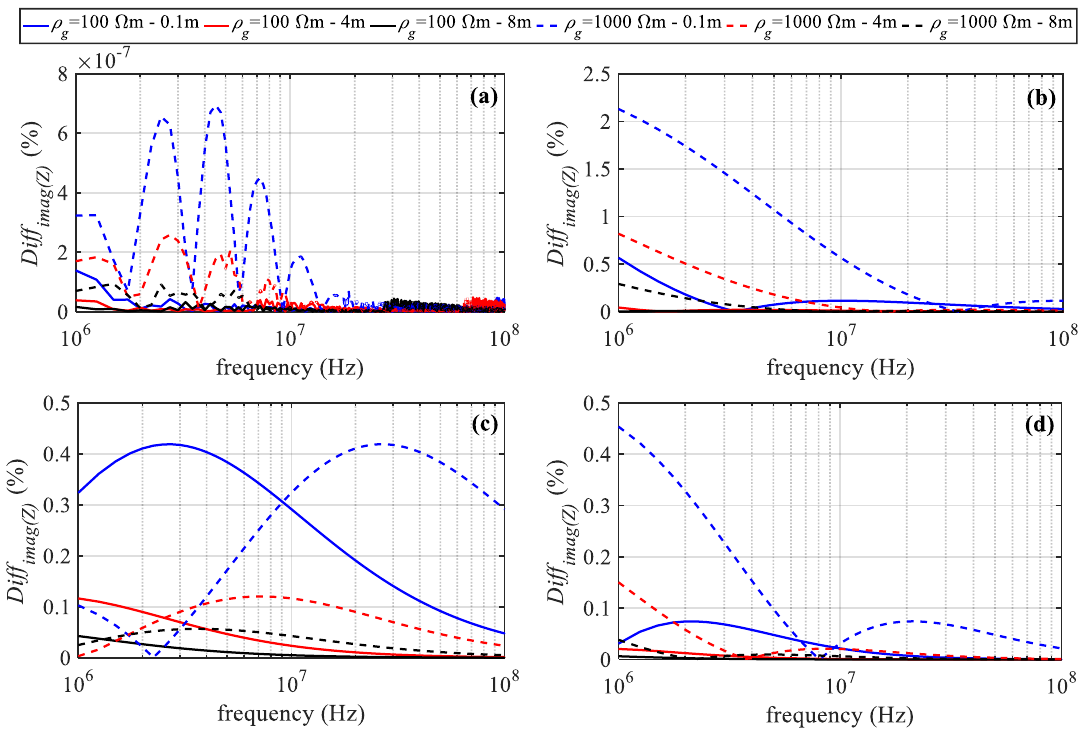
Figure 16. Di ff erences in the imaginary part of Z 13 in NB using the closed-form expression of ( a ) Carson, ( b ) Dubanton ( c ) Noda and ( d ) Alvarado-Betancourt.